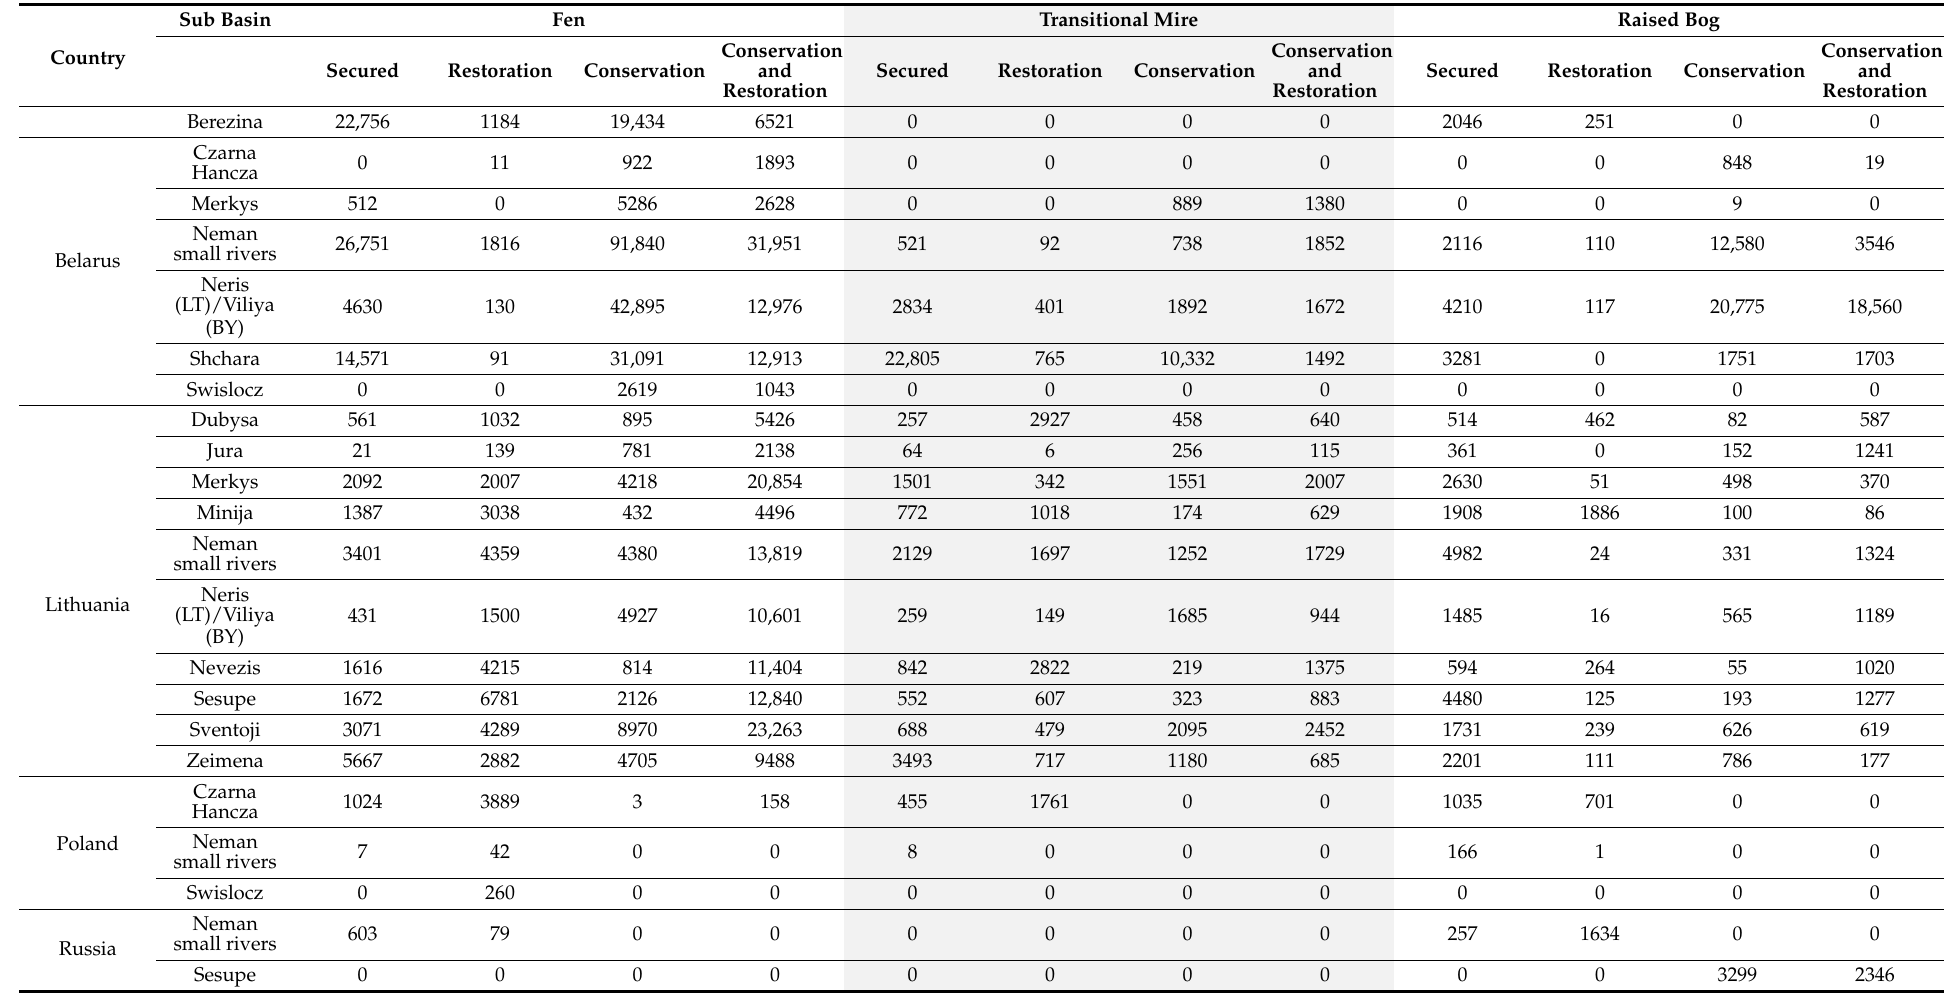
Table 3. Areas of secured peatlands (i.e., protected and are not impacted by drainage) and opportunities for peatland restoration (i.e., protected but impacted by drainage), peatland conservation (i.e., not protected and are not impacted by drainage), and peatlands that need both conservation and restoration (i.e., not protected and impacted by drainage) within the hotspots of the key peatland cluster analysis (Figure 7) of the Neman River basin for the three peatland types by country and sub-basin.